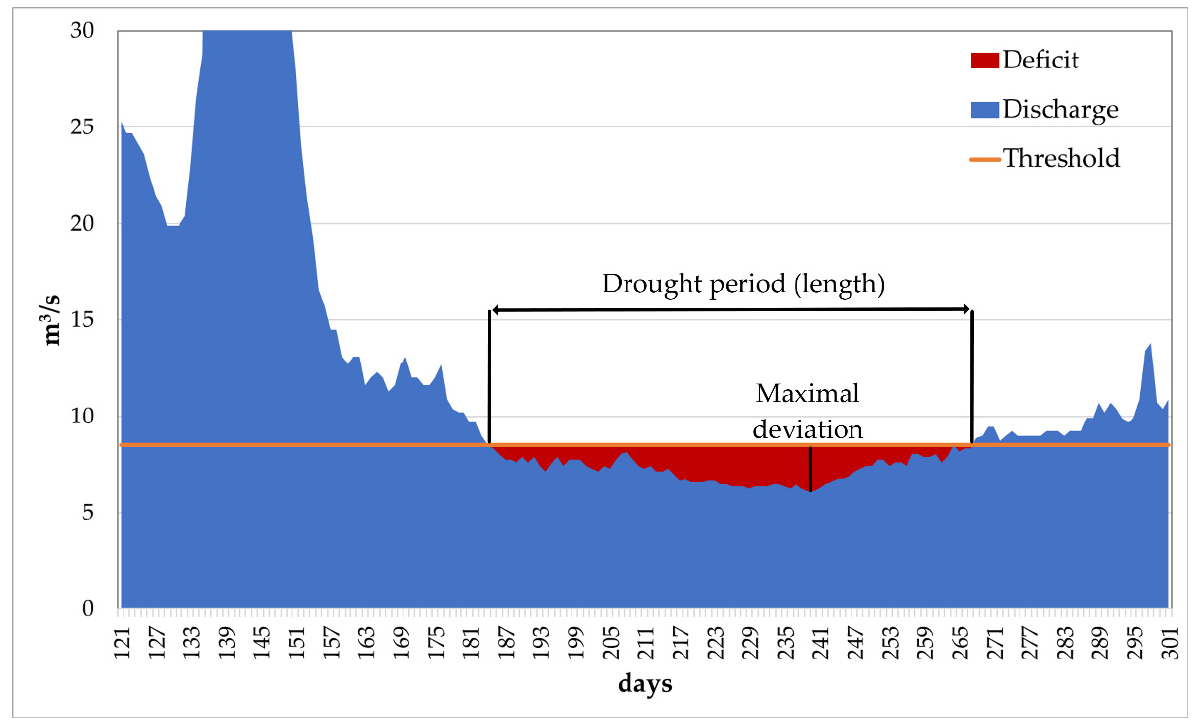
Figure 3. Principal scheme of TLM tool.